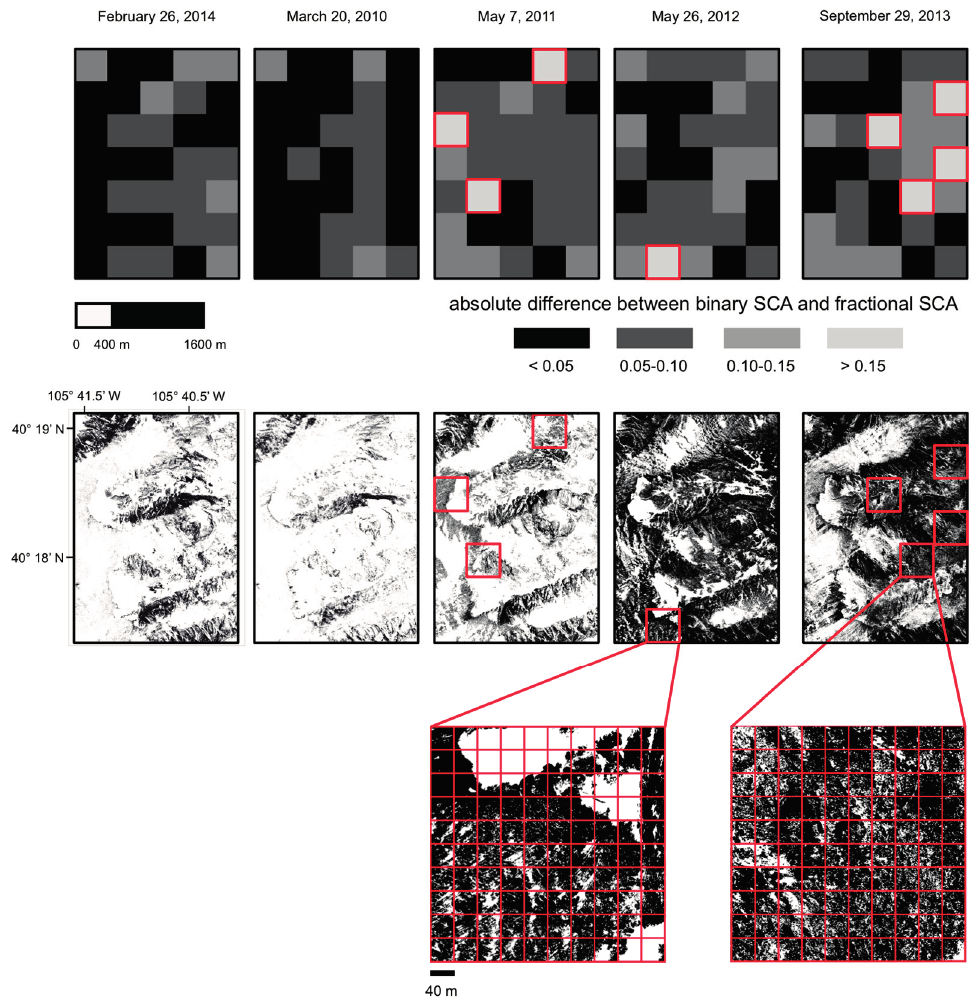
Figure 12. Spatial distribution of 400 × 400 m blocks from the Rocky Mountain NP imagery study area where absolute differences between binary and fractional SCA were low (< 0.05), medium (0.05–0.10), high (0.10–0.15), and highest (>